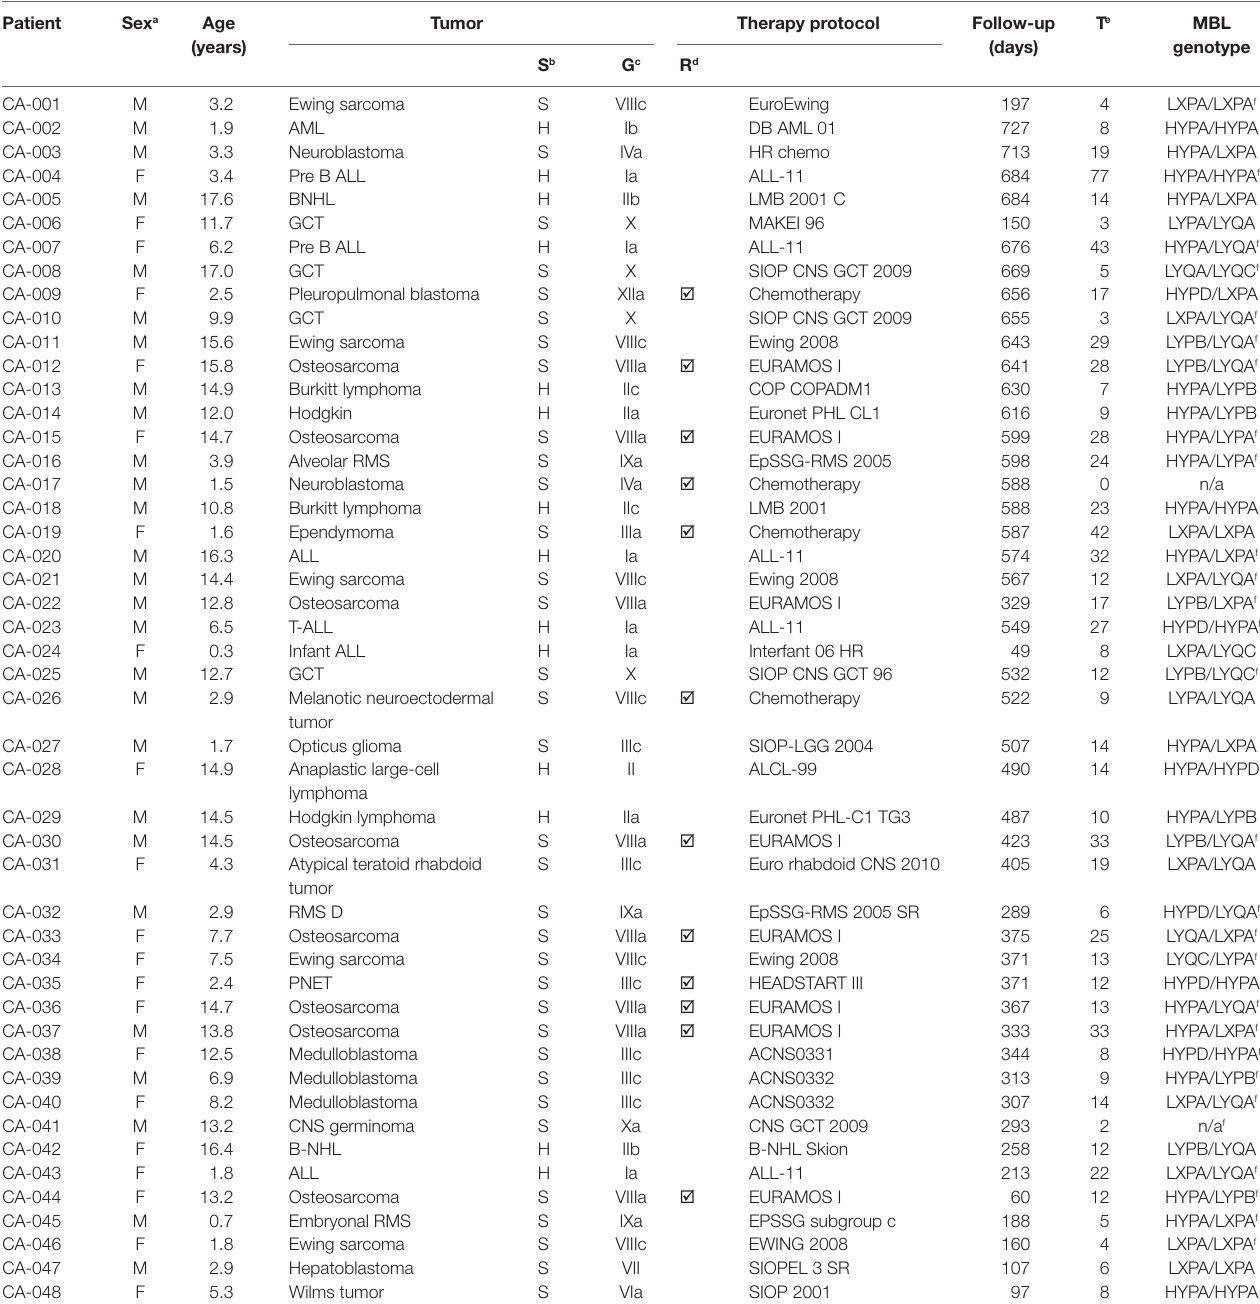
TaBle 1 | Patient